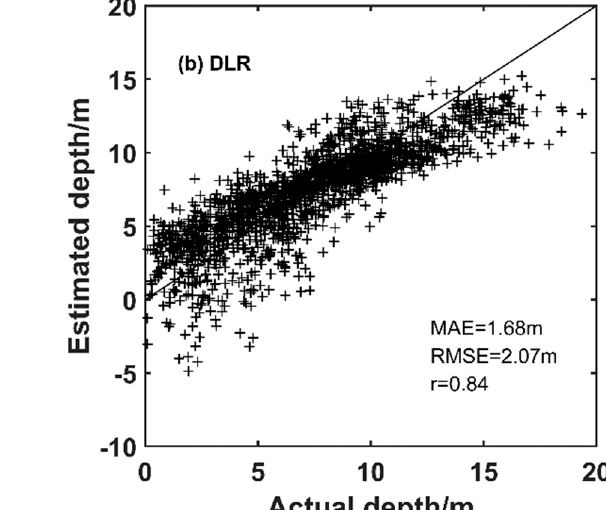
Figure 8. Scatter plots on the actual and inverted water depth of Ganquan Island: ( a ) P-DLA, ( b ) DLR.